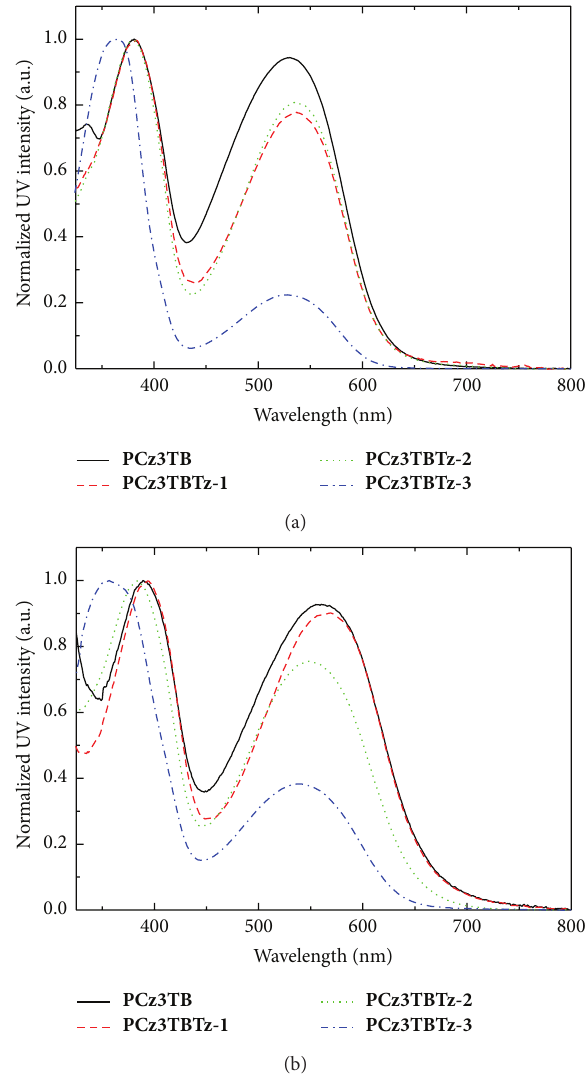
Figure 2: UV-Visible absorption spectra in (a) solution and (b) film.